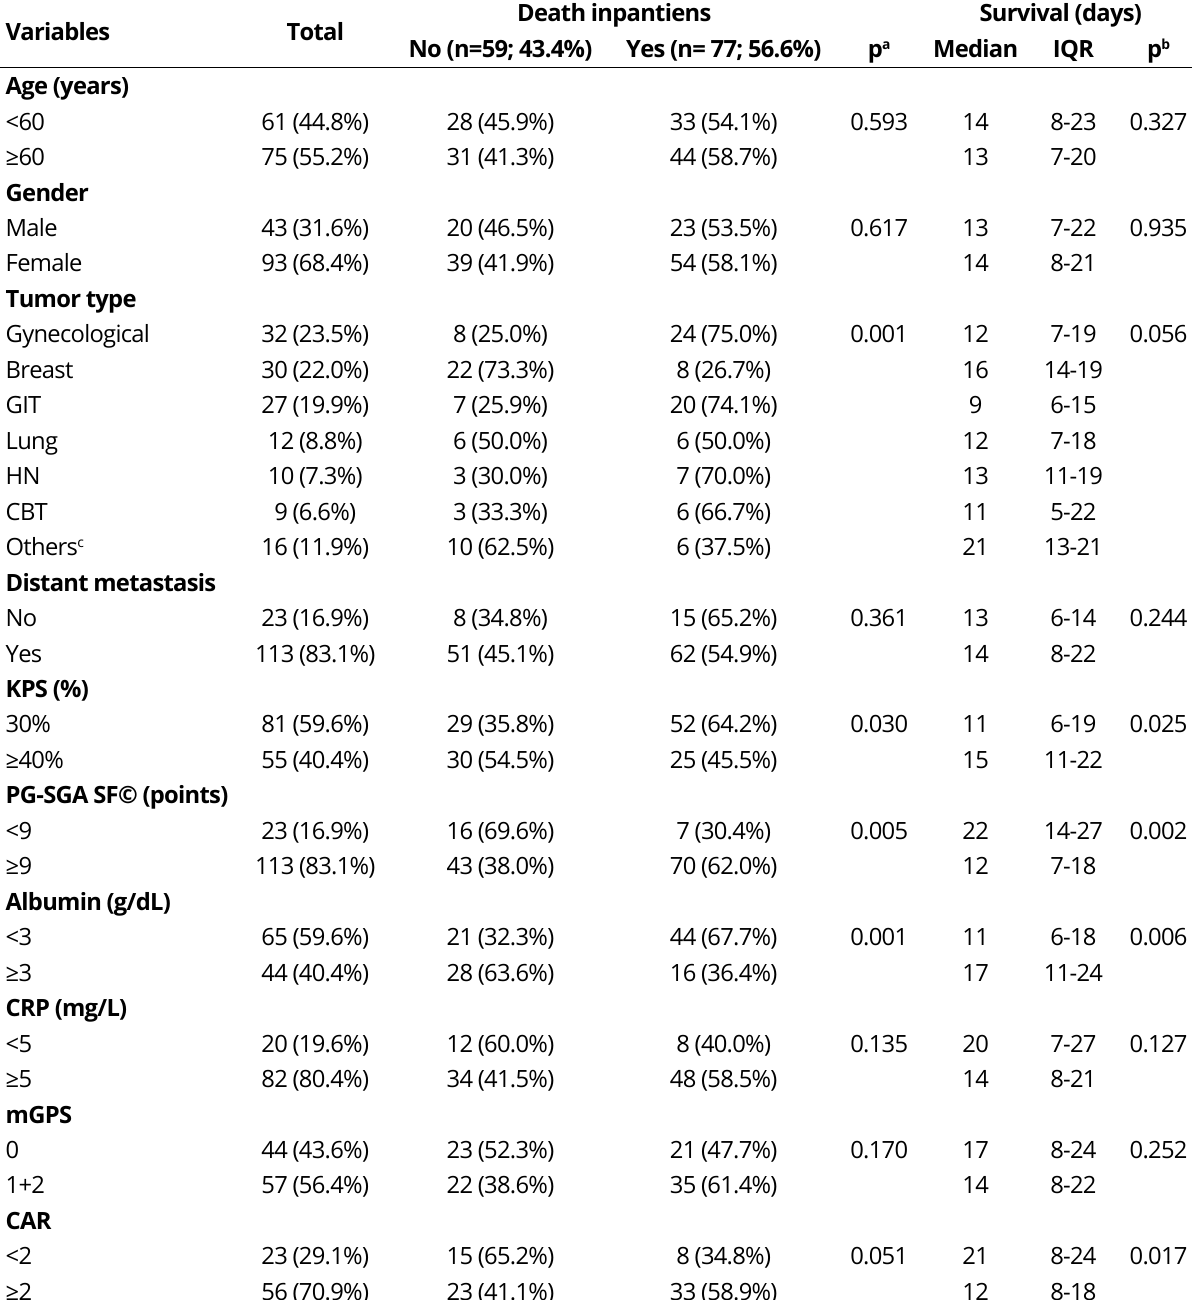
Table 1. General characteristics and median survival of inpatients with advanced cancer